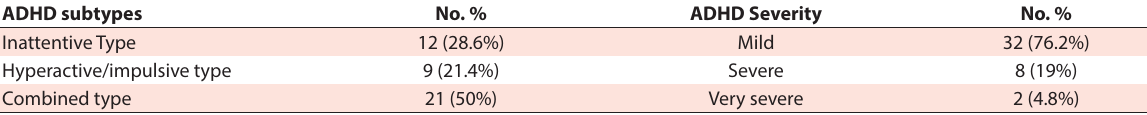
Table 4. ADHD subtypes and severity in adolescents with ADHD ADHD subtypes